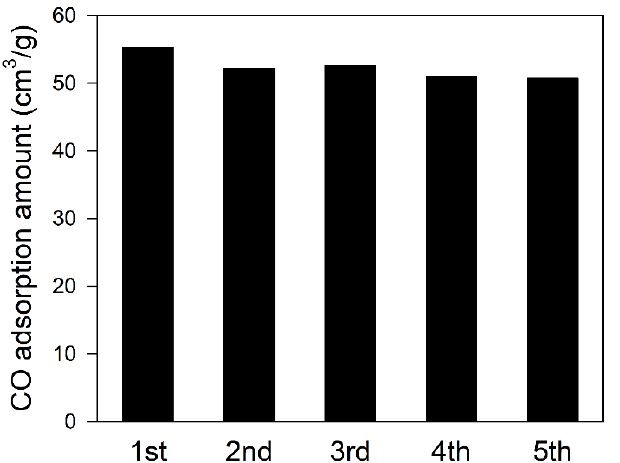
Figure 8. Determination of the potential reuse of i-Cu(I)/ θ -Al 2 O 3 -500 adsorbent for five cycles of the CO adsorption test.